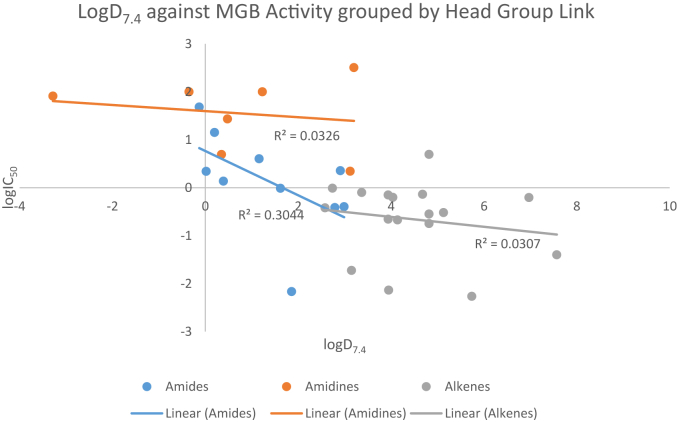
LogD7.4 against MGB activity grouped by head group link.